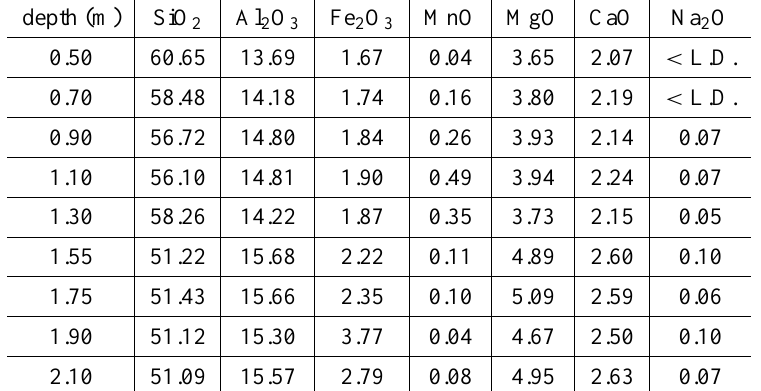
Bulk chemical analyses (%), cation exchange capacity (CEC) and total surface area (TSA) of samples from the massive bentonite